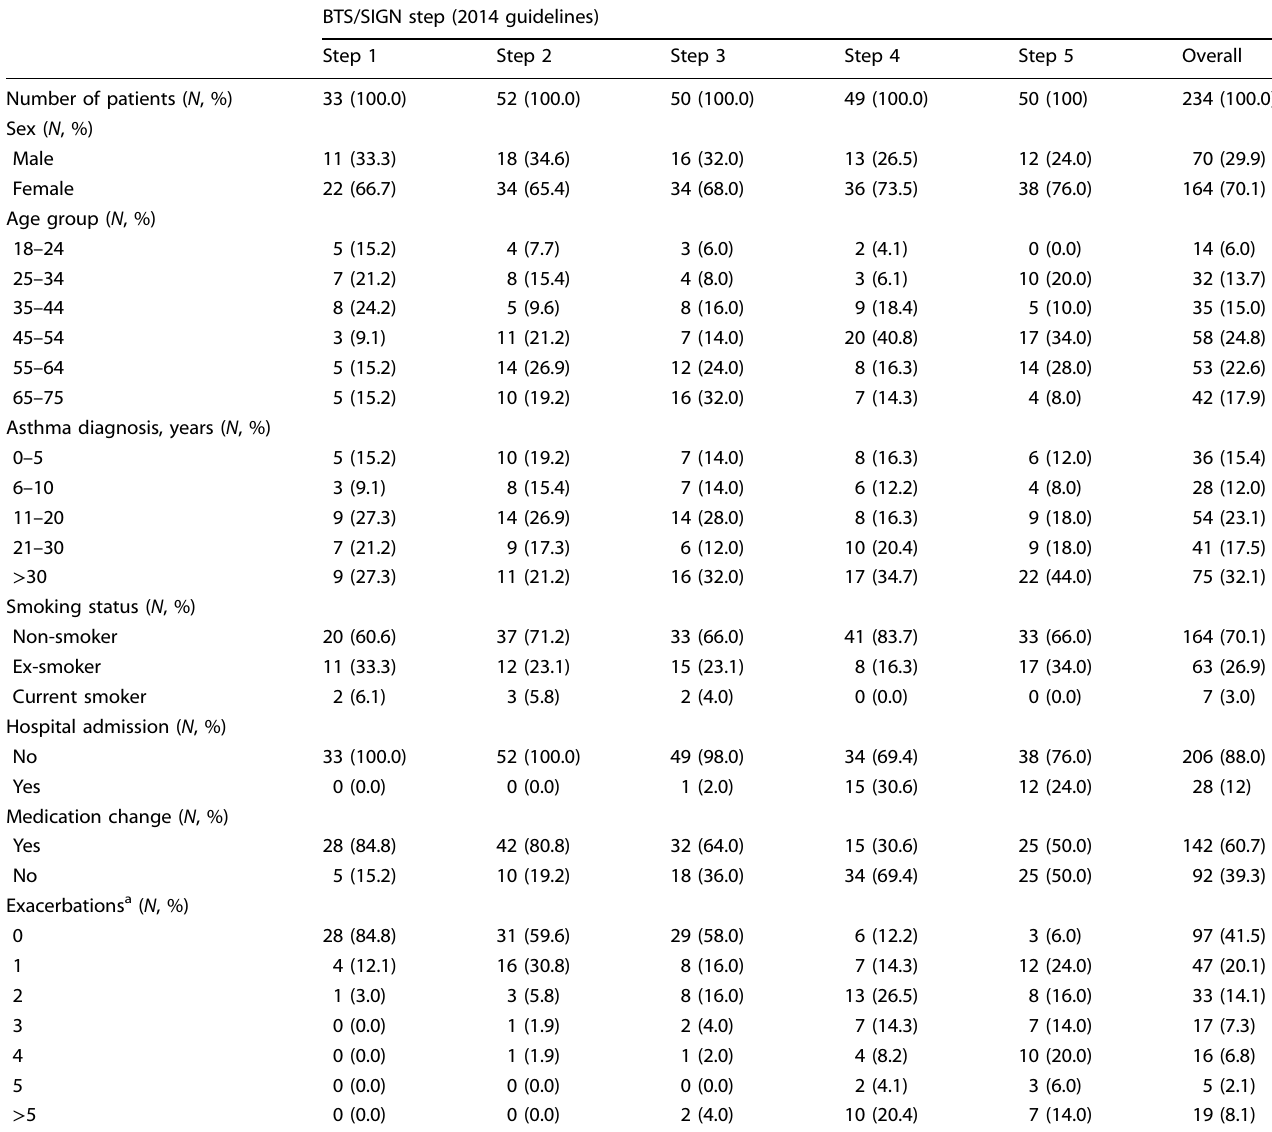
Table 1. Baseline demographics and disease